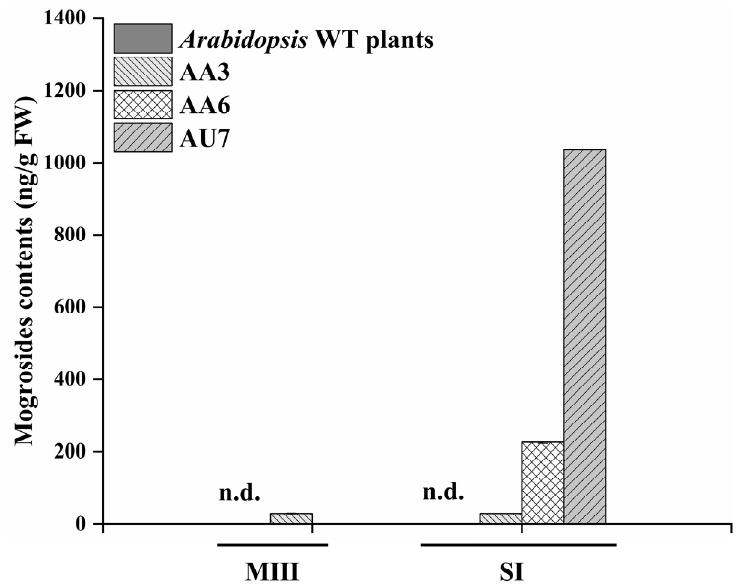
Figure 6. Accumulation of mogrosides in transgenic Arabidopsis lines AA3, AA6, and AU7. n.d., not detected. The data are presented as the mean values ± SDs, n = 3 biologically independent samples.